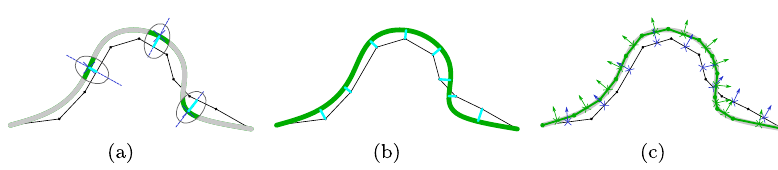
Fig. 1 Exemplary 2D sketches for different types of discrepancy measures between experiment (green) and discretized forward model (black). Portions of the observed interface that are accounted for are given in green and unconsidered portions are given in gray. a Euclidean distances d i mp at measurement points in preset directions in light blue, b closest point projection distances d i cpp for all nodes in light blue, c triangulation centers n c i as crosses and normal vectors i of equal length as arrows for triangulations of the experimentally observed interface in green and the forward model result in blue. Detailed explanation in text